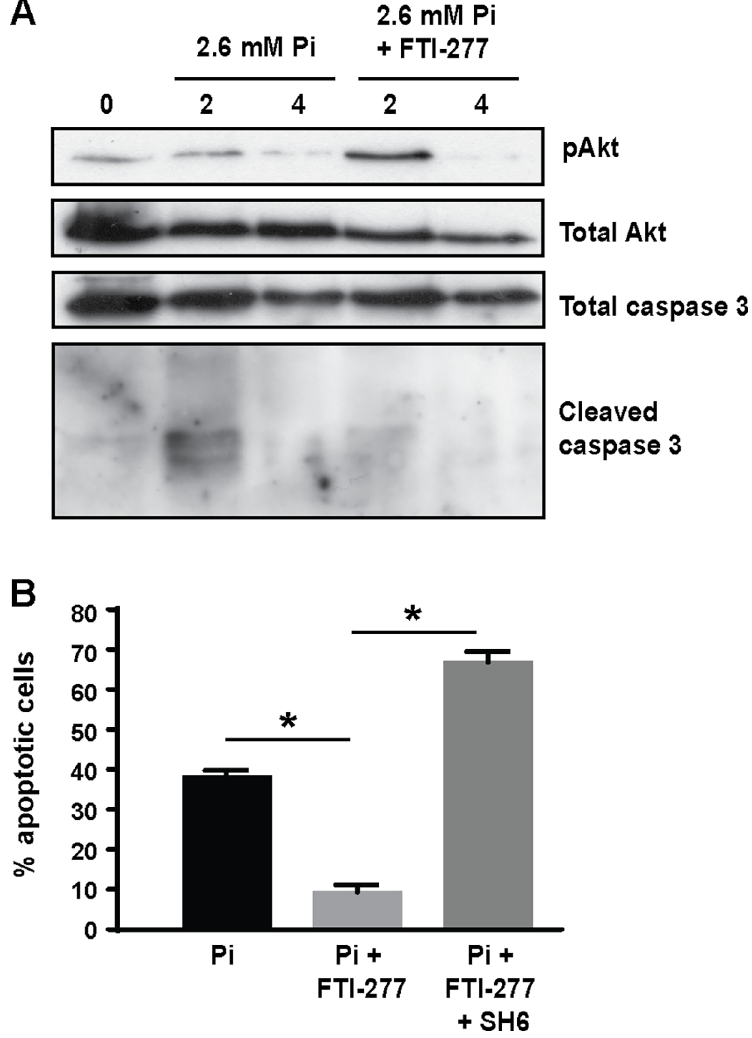
hours later and analysed by western blotting. ( B ) Human VSMCs incubated in serum-free medium containing phosphate (2.6 mM) ± FTI-277 (10 μ M) ± SH6 (10 μ M) for 12 hours were fixed and stained with DAPI. Apoptotic cells are expressed as a percentage of total cells (mean ± SEM); > 750 cells were counted per variable. Data were analyzed by one-way ANOVA and Tukey post-hoc tests; (cid:3) p <